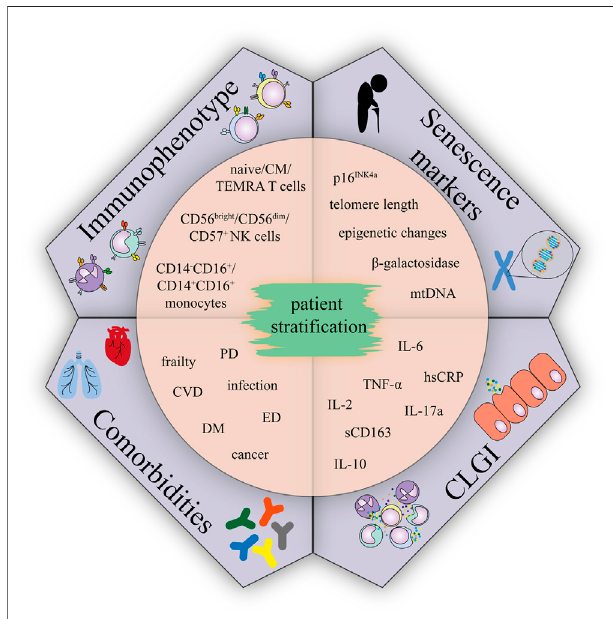
FIGURE 3 | Immunophenotype, comorbidities, CLGI, and senescence markers suggested for CCS patient strati fi cation.; Abbreviations: CM, central memory; TEMRA, terminally differentiated effector memory T cells re- expressing CD45RA; CVD, cardiovascular disease; DM, diabetes mellitus; ED, endocrinal disease; PD, pulmonary